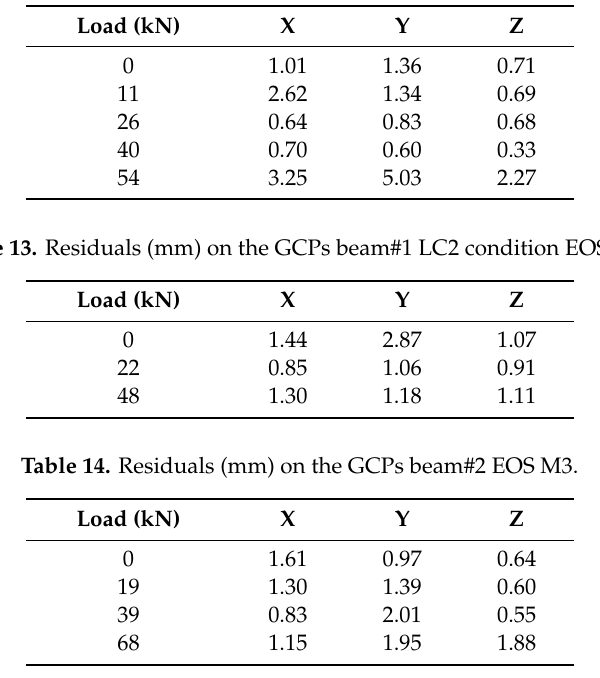
Table 12. Residuals (mm) on the Ground Control Points (GCPs) beam#1 LC1 Powershot.